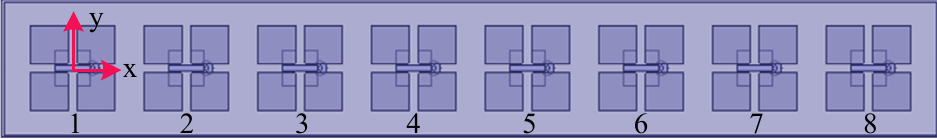
Figure 9. Configuration of the 8-element linear array based on ME dipole.